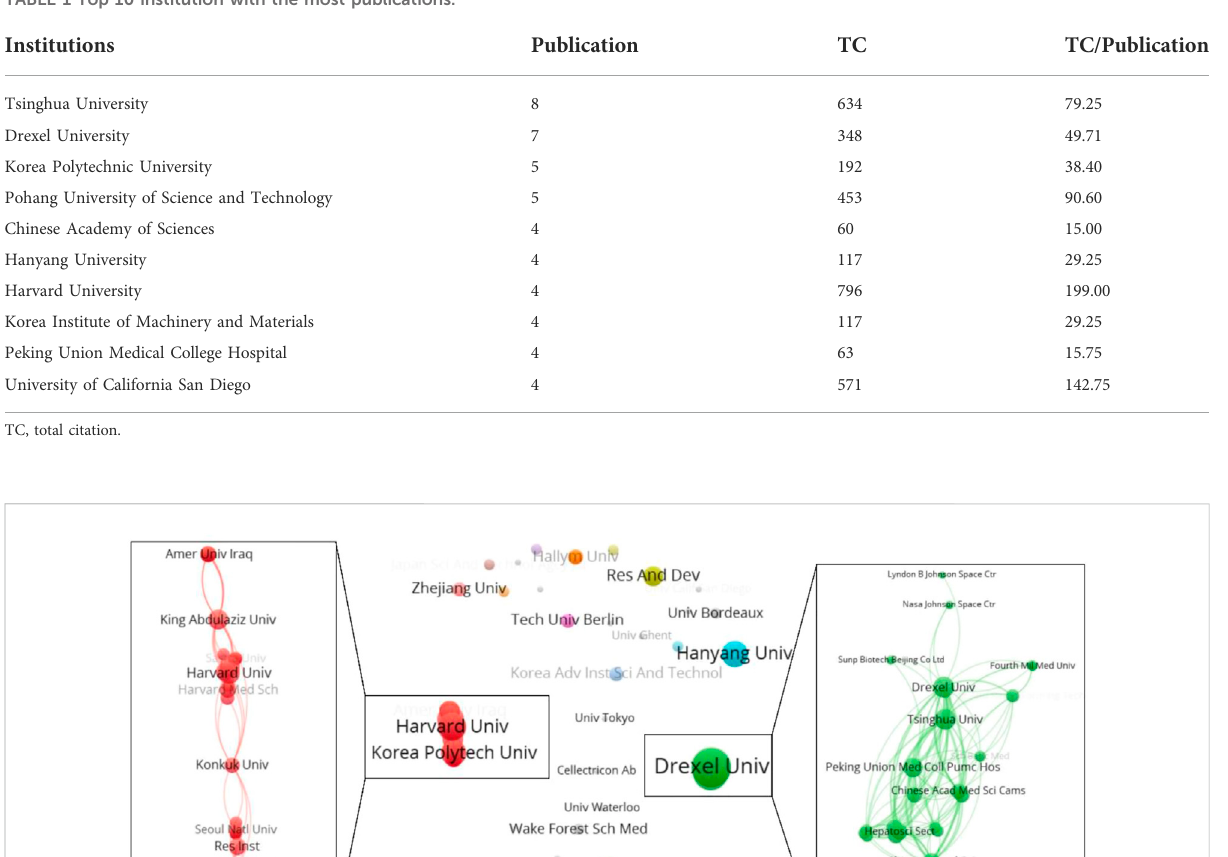
TABLE 1 Top 10 institution with the most publications.